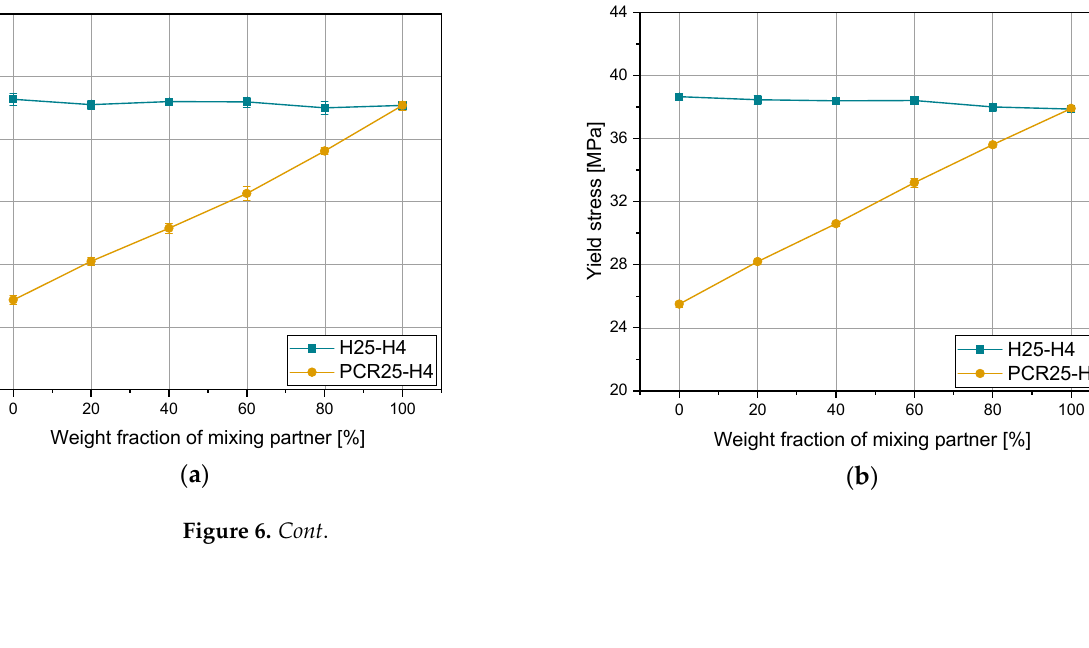
Figure 5. Property profiles of H25, PCR25, and H4.